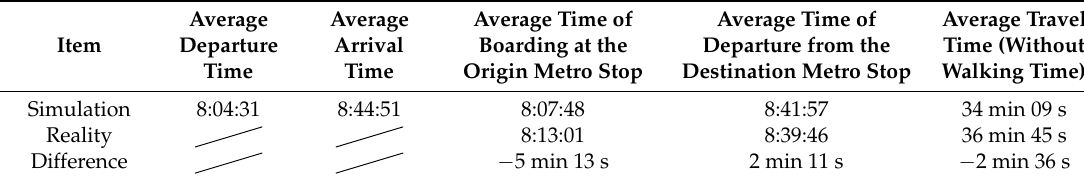
Table 4. The differences between simulation and reality when going to work.